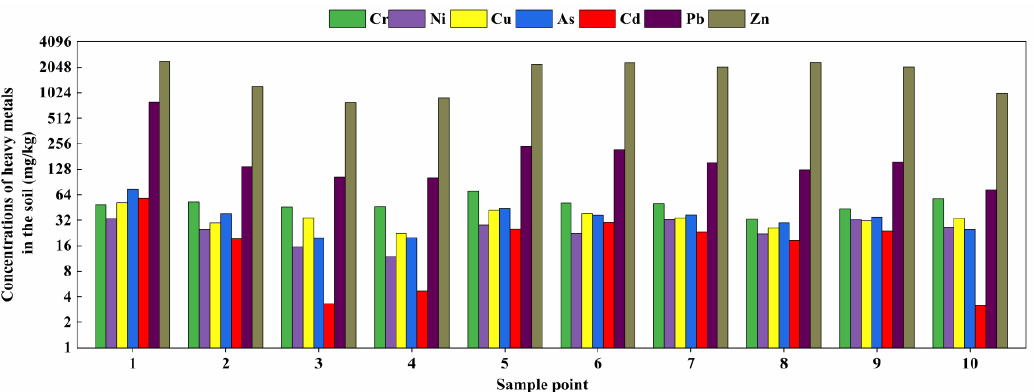
Figure 4. Heavy metal contents in farmlands. Sampling points are the same as in Figure